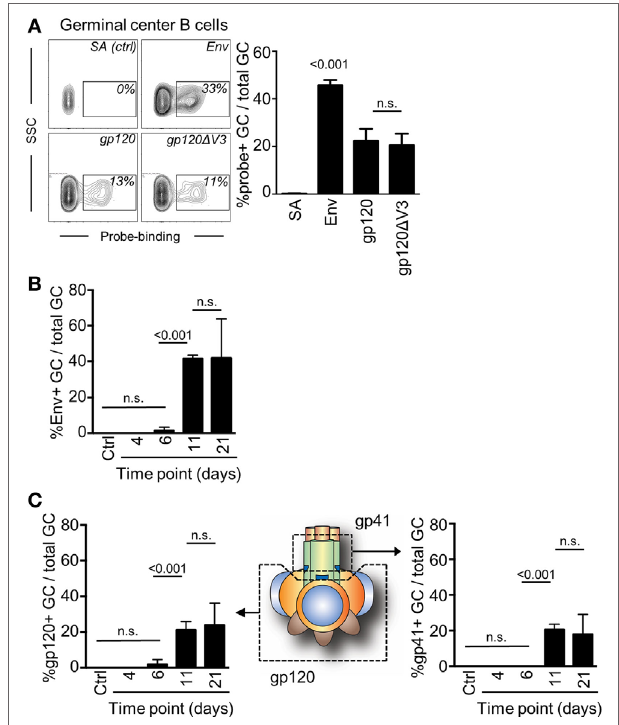
FigUre 3 | Detection of antigen and subunit-specific germinal center (GC) B cell responses after a single injection of mice with Env. (a) The frequency of GC B cells (B220 + IgD − GL7 + CD95 + ) 11 days after injection which were able to bind biotinylated Env, gp120, or gp120 Δ V3 was assessed by flow cytometry after addition of APC-conjugated streptavidin. Staining of cells with APC-conjugated streptavidin (SA) in the absence of Env was used verify the specificity of the binding. (B) The frequency of Env-specific GC B cells of total GC B on days 6, 11, and 21 after injection of mice with Env is shown. (c) The frequency of GC B cells (B220 + IgD − GL7 + CD95 + ) that could bind to the gp120 subunit of Env was assessed in a similar manner (left panel). By subtraction of the gp120-specific GC B cells from the total Env-specific GC B cells, we could also determine the proportion of gp41-specific GC B cells that had been induced at the same time points (right panel). N = 4–5 animals per